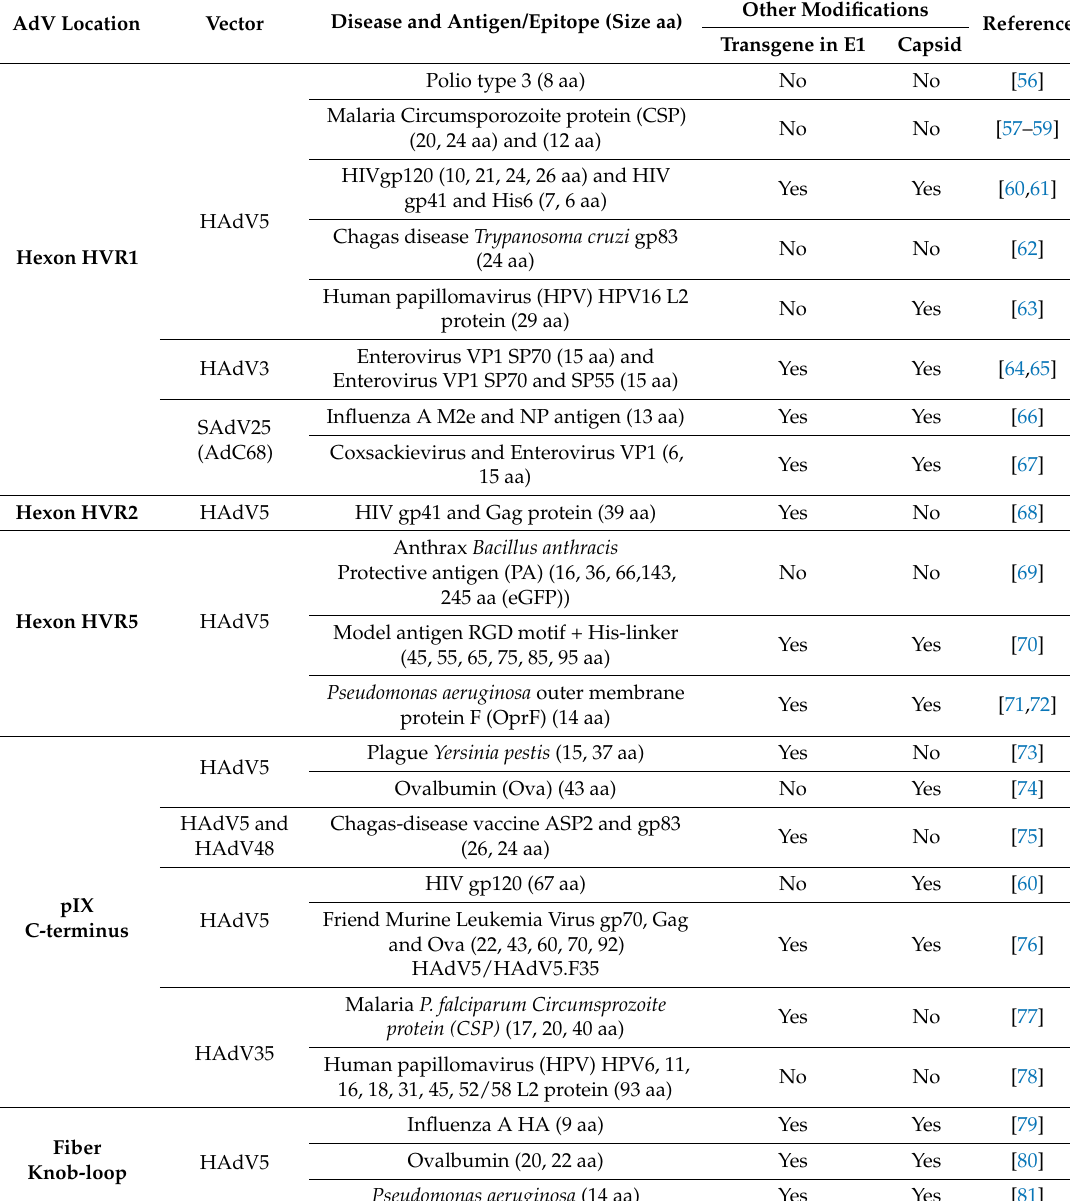
( C ) pIX can display 240 copies of linear peptides or globular proteins (blue) by fusion of the antigen (blue) to the C-terminus (with or without a spacer, dotted line). AdV.pIX display vectors are generated with or without a genetically encoded transgene in E1 (green). ( D ) Epitopes can be inserted in fiber protein HI-, DE-, FG-, CD-, loops and C-terminus. For example, HI-loop (purple) AdV.Fiber display vectors contain 36 copies per capsid and can be generated with or without a genetically encoded transgene in E1 (green). ( E ) Penton Arg-Gly-Asp (RGD) loop (yellow) can be modified to present linear epitopes, resulting in 60 copies of epitopes per AdV capsid (AdV.Penton) with or without a without a genetically encoded transgene in E1 (green). Right and left Inverted terminal repeat (RITR-LITR). Table 1. AdV-display